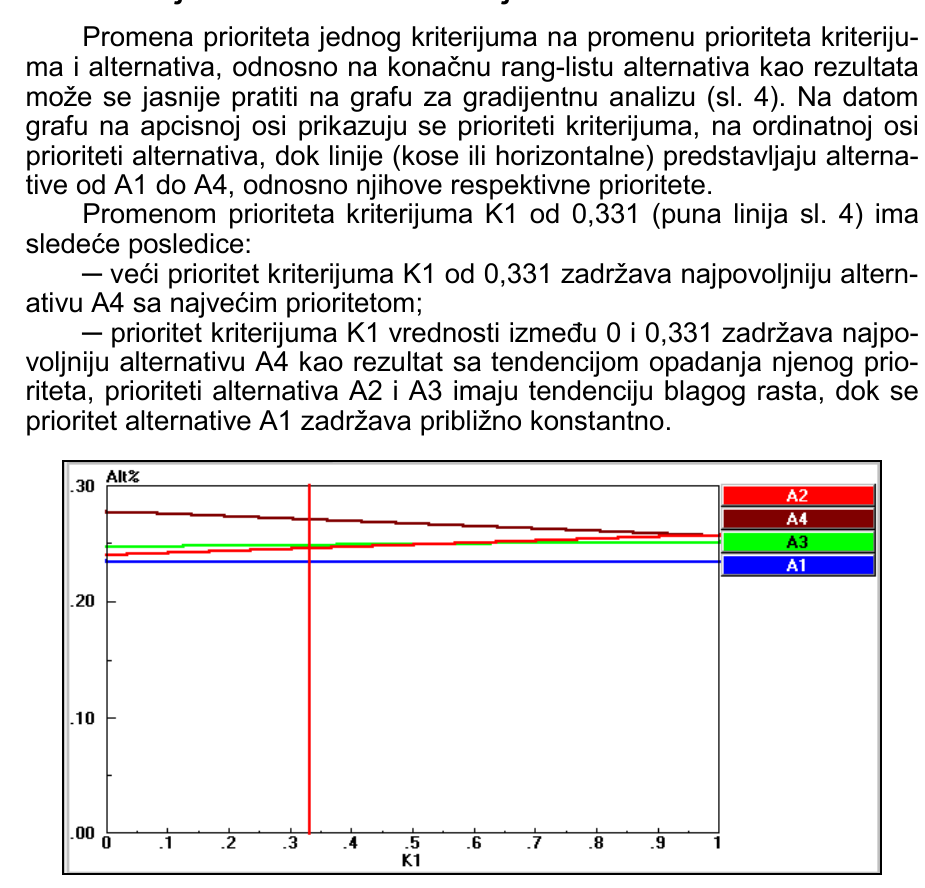
Figure 4 – Gradient sensitivity analysis of the K1 priority